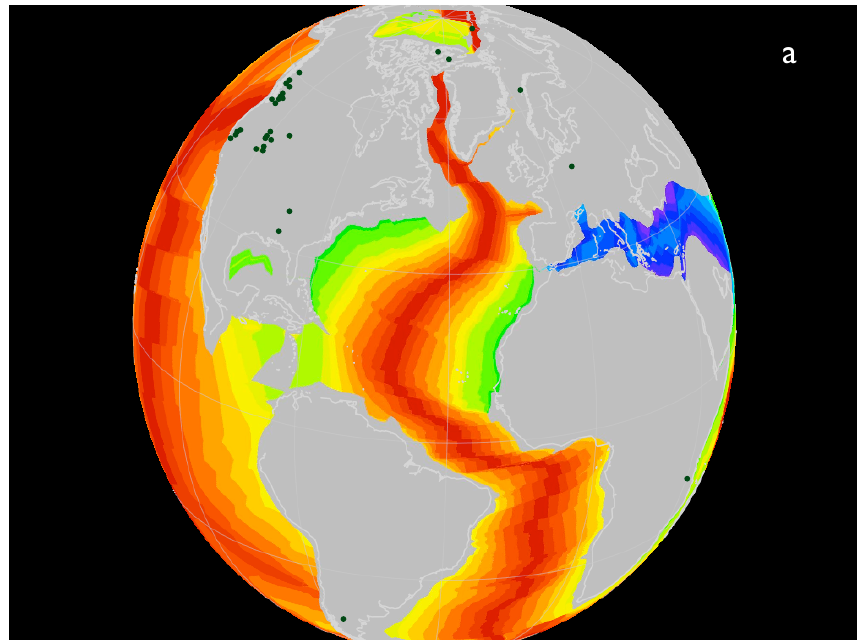
Fig. 1a. Comparison of paleogeographic information used in the simulation with independent reconstructions from Mueller et al. (2008) via the freely available GPLATES software and via personal communication from Paul Markwick. In (a) a plate tectonic reconstruction for 55mya from GPLATES including sea floor age is shown. Terrestrial paleoclimate proxy localities are indicated on this map with green circles. The modern continental boundaries in their 55mya positions as reconstructed by GPLATES compard with Markwick’s paleogegraphy are shown in (b, d) . The topography used in model (c, e) is compared with the independently derived high resolution early Eocene topography of Markwick (based on Markwick (1998)) (b, d) . In these figures, the paleoclimate proxy localities are indicated with magenta circles. The GPLATES derived plate configuration is a reasonable match to the land-sea distribution developed in Sewall et al. (2000) used in the simulations here (c, e) . It should be noted that in some cases GPLATES derived paleolocations must be adjusted slightly to fall on land or to be in the right location with respect to topography, as described in the text. In (f) an example of how the pointwise comparison of model and proxy records is performed is shown. Colors are modelled temperatures and the text indicates the abbreviated names of proxy localities. Based on modern latitude and longitudes the localities are rotated back to 55mya positions using GPLATES, thus enabling the best objective placement of the paleo-positions within the model’s reference frame. As (f) shows, errors in paleo-position are unlikely to introduce large errors in inferred temperature except in regions with strong temperature gradients, i.e. in regions of strong elevation